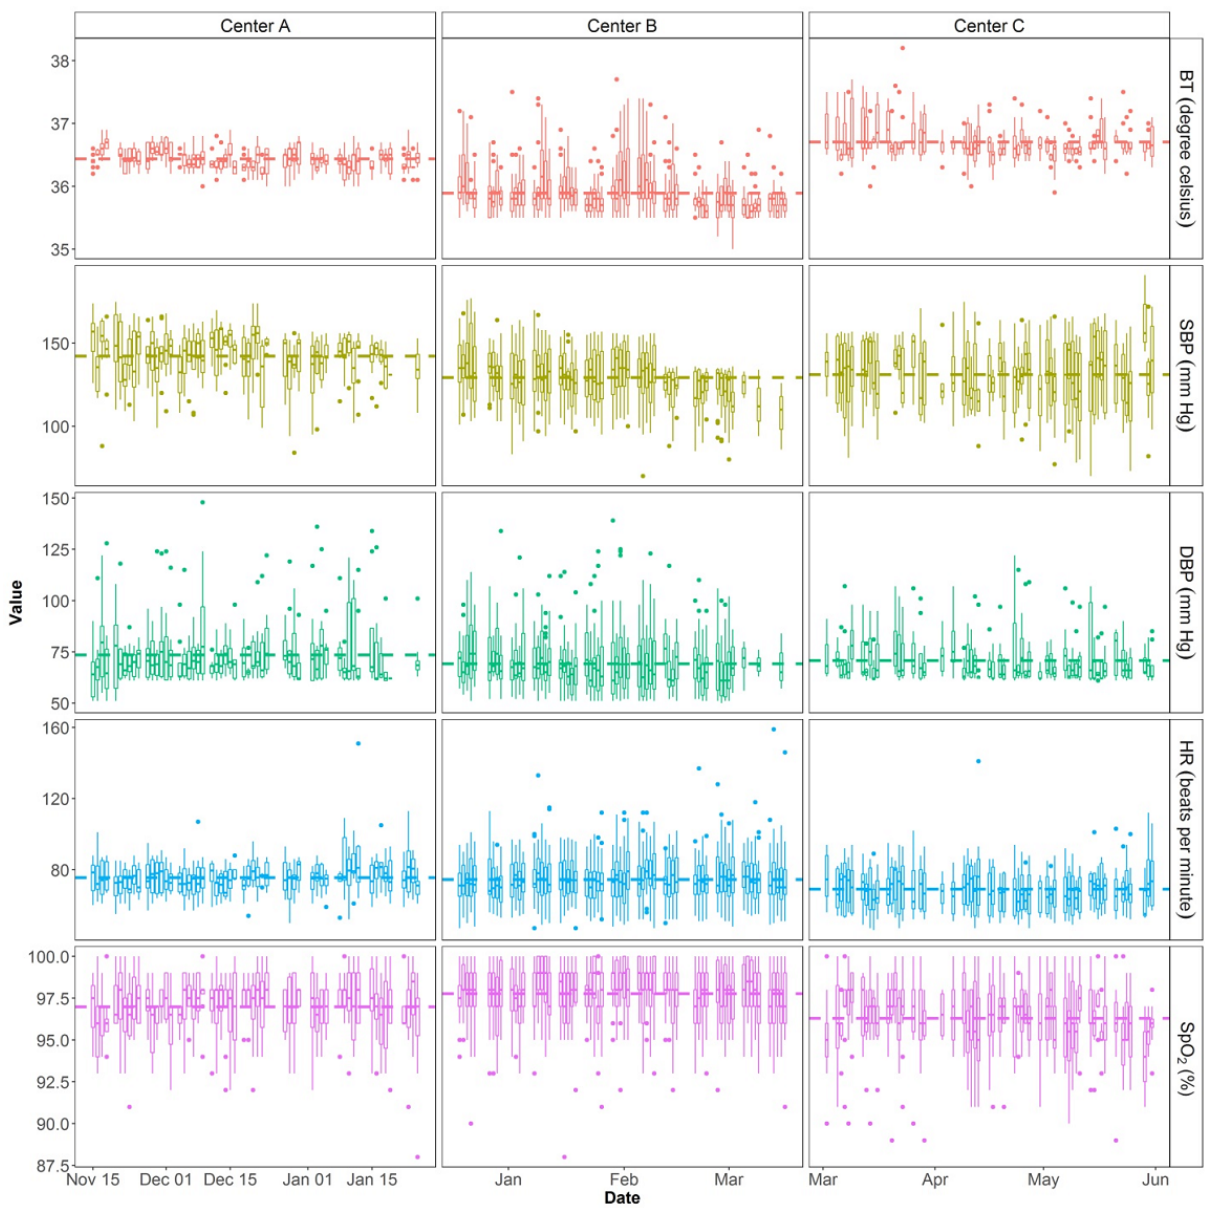
Figure 3. Vital signs of each participant from the 3 centers over time. The dashed lines represent mean values. BT: body temperature; DBP: diastolic